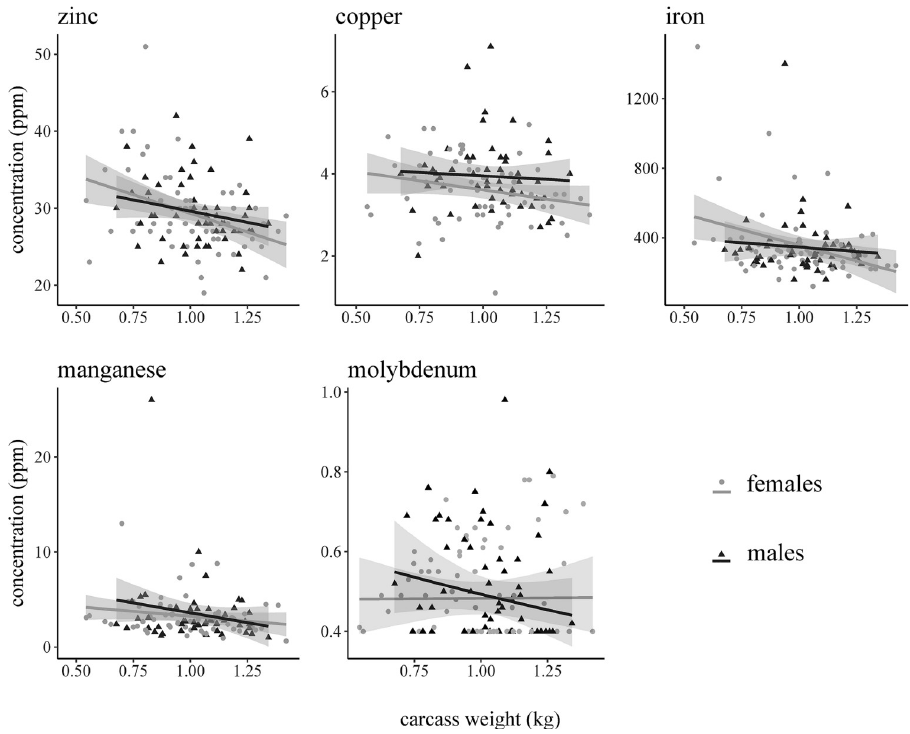
Fig 8. Graphical representation of a Bayesian censored analysis of covariance model depicting relationships between muskrat ( Ondatra zibethicus ) carcass weight (kg) and heavy metal concentrations (ppm, wet weight) for each